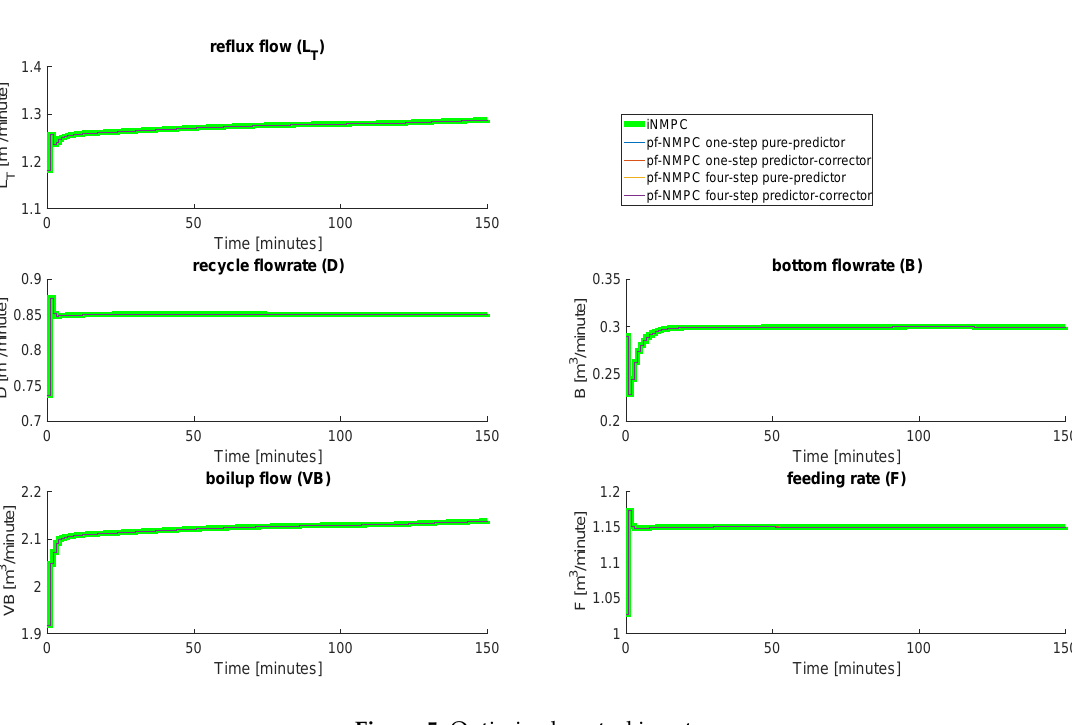
Figure 4. Recycle composition, bottom composition, reactor concentration, and reactor holdup.